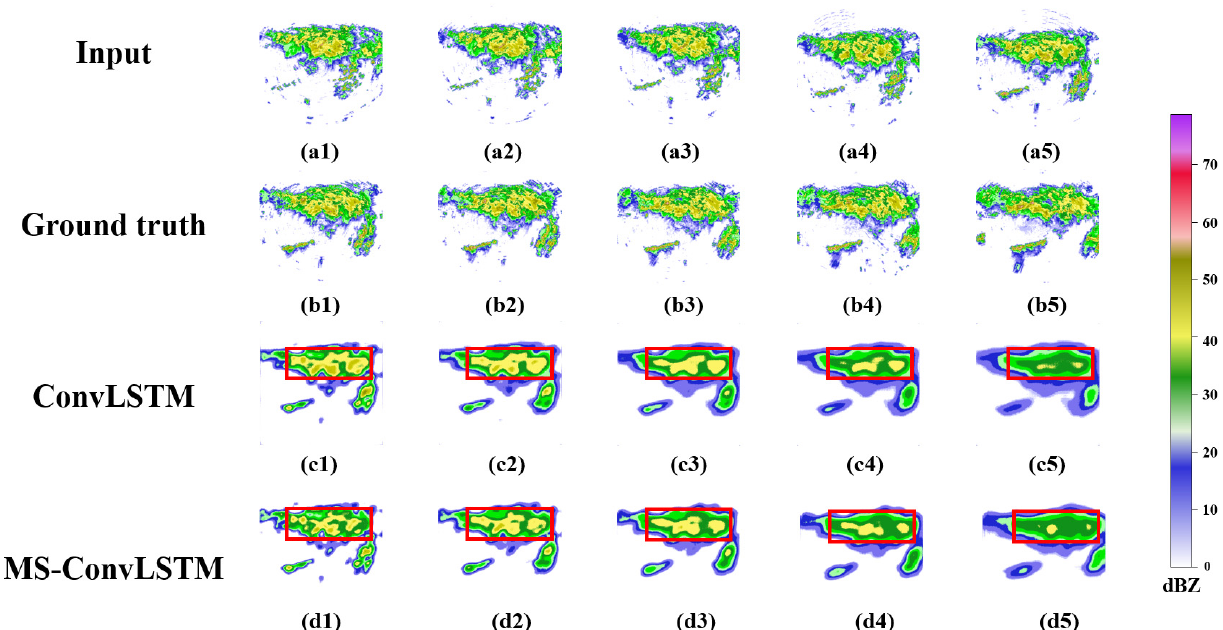
Figure 4. The visualization results of test sample 1: ( a1 – a5 ) represent part of the input of the model; ( b1 – b5 ) the ground real radar echo charts of 6, 18, 30, 42 and 60 min; and ( c1 – c5 ) and ( d1 – d5 ) are the corresponding prediction results of ConvLSTM and MS-ConvLSTM, respectively.